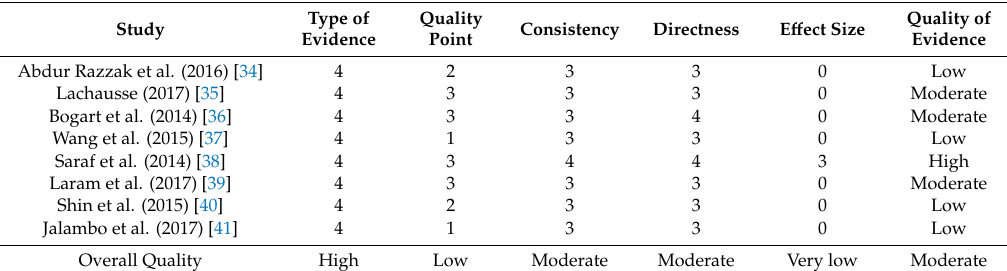
Table 4. GRADE result for the eight individual